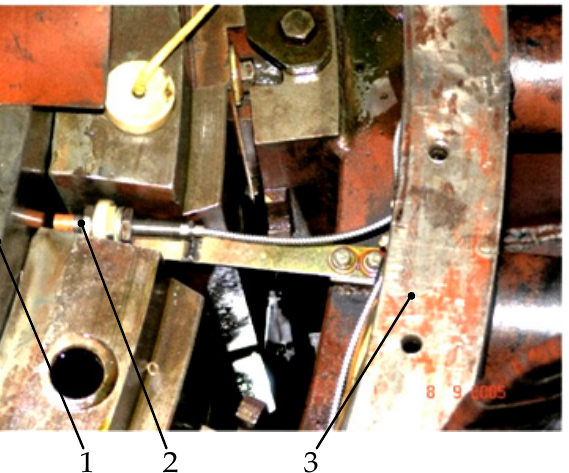
Figure 2. Installing sensors for rotating shaft vibration measurement: 1—shaft, 2—sensor,